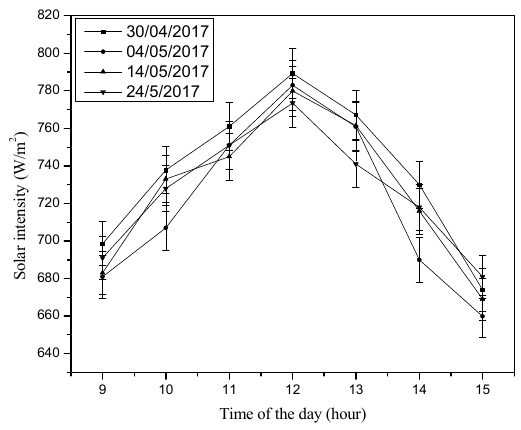
Figure 5. Variation of solar intensity with time of day.